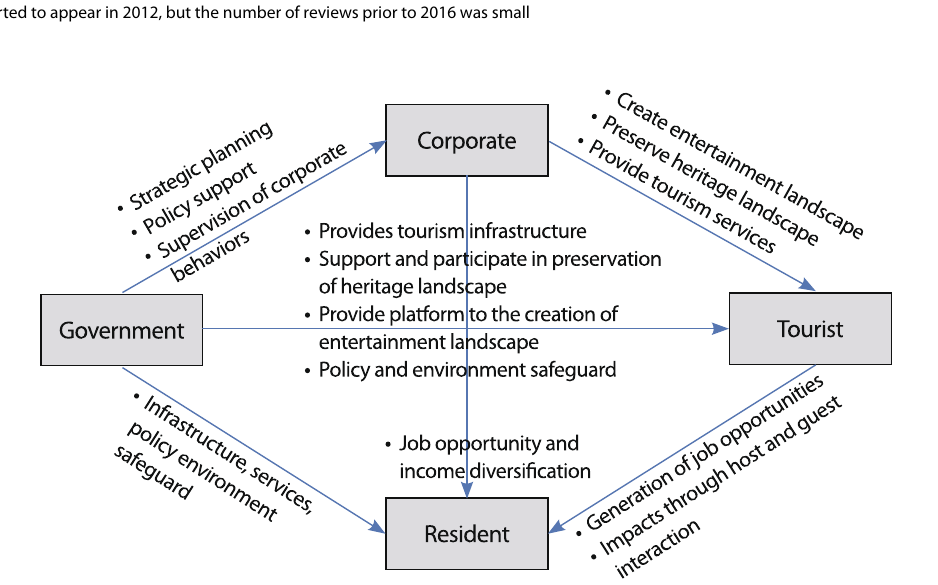
Tourist reviews started to appear in 2012, but the number of reviews prior to 2016 was small